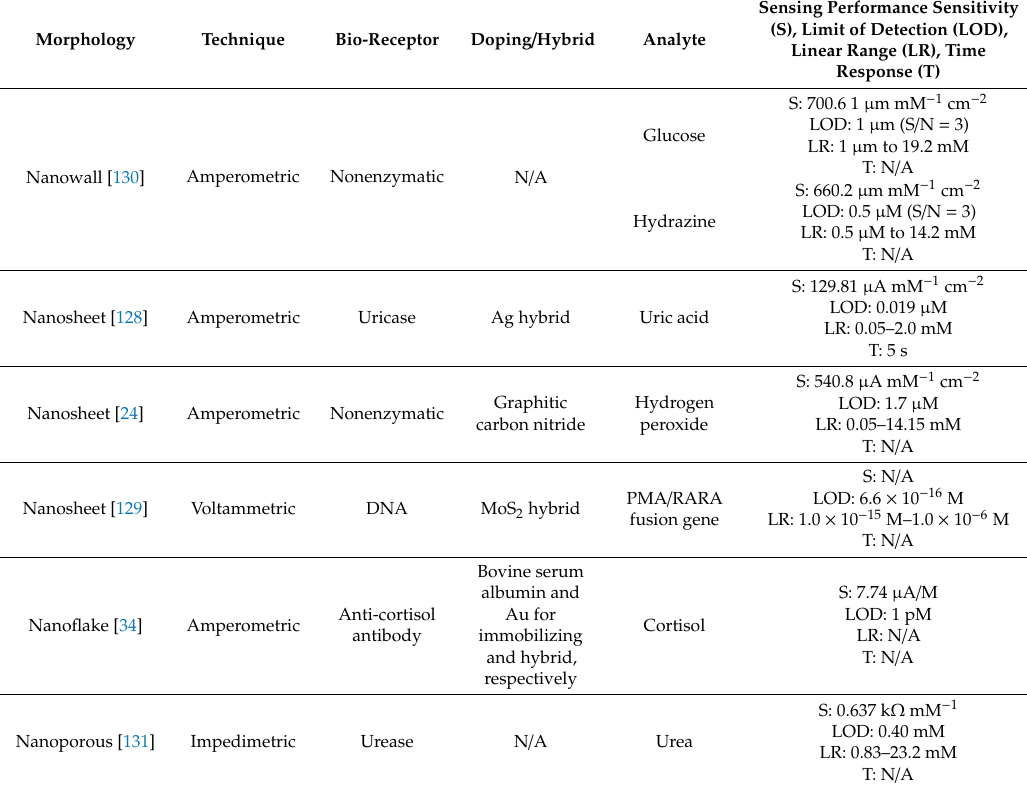
Table 3. Di ff erent techniques of 2-D ZnO-based electrochemical biosensors for various analyte detections, since 2014.